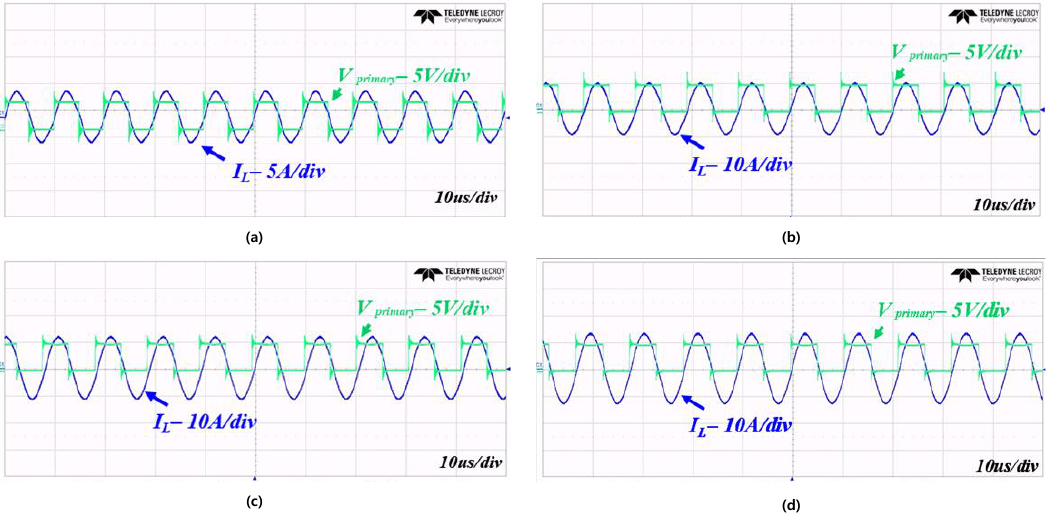
Figure 15. Wave of primary voltage and current; ( a ) d = 5 cm, Ro = 10 ohm; ( b ) d = 8 cm, Ro = 10 ohm; ( c ) d = 9 cm, Ro = 10 ohm; ( d ) d = 10 cm, Ro = 10 ohm.